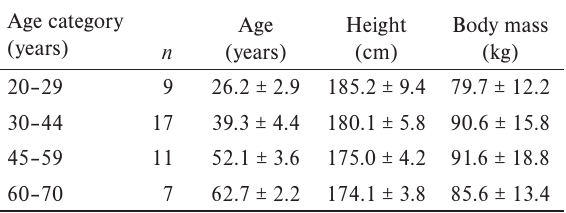
Characteristics of table tennis players (mean ± SD)